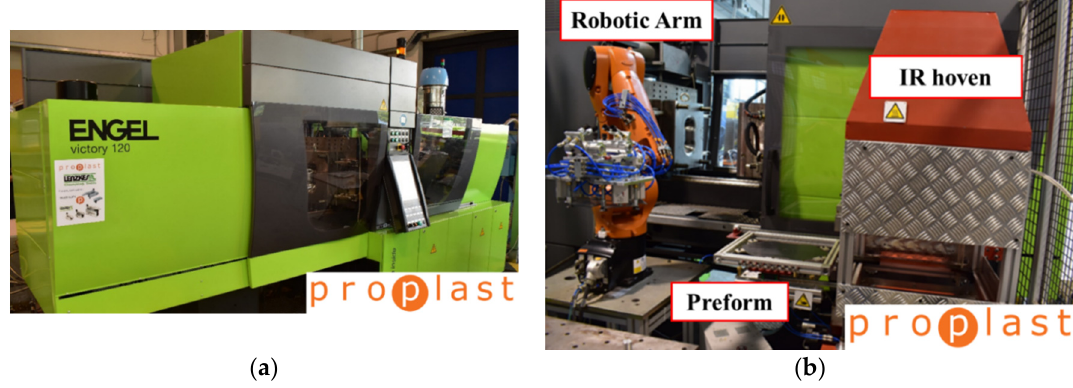
Figure 7. Engel Victory 500/120 press ( a ) and thermoforming equipment ( b ).